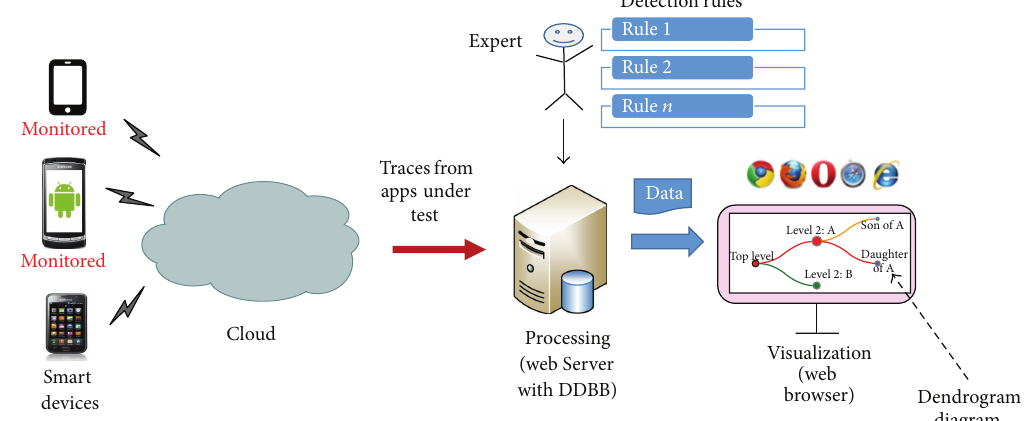
Figure 1: Overview of the monitoring